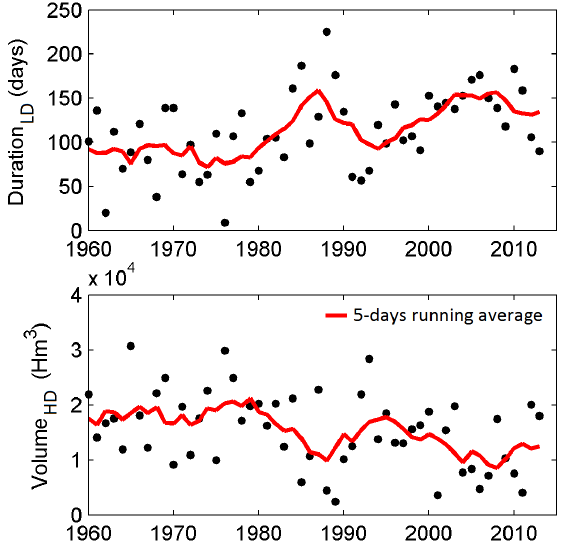
Figure 15. Evolution of the duration of low discharge period (Duration LD ) and the water volume during high discharge periods (Volume HD ) between 1960 and 2013 (calculated from discharge data available on http://www.hydro.eaufrance.fr/); red lines repre- sent 5-day running averages in order to highlight the